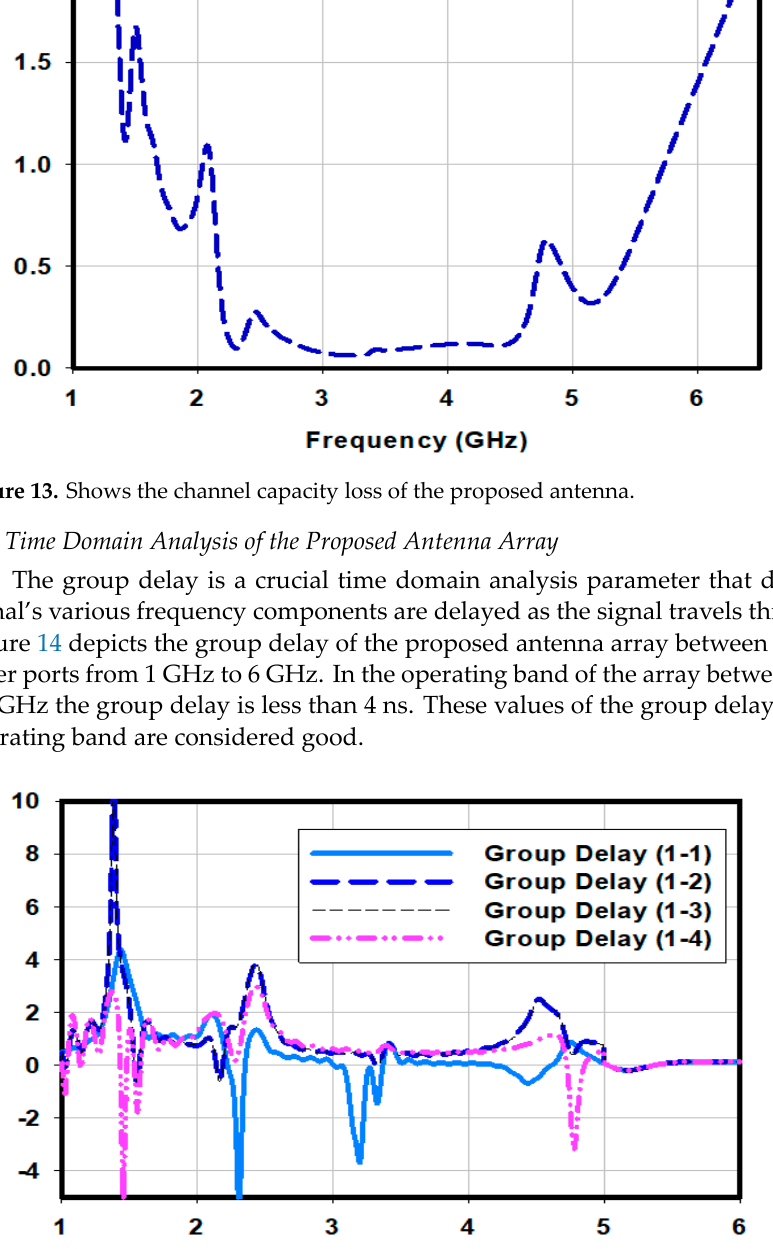
Table 2. Comparison of proposed antenna array with previous works.